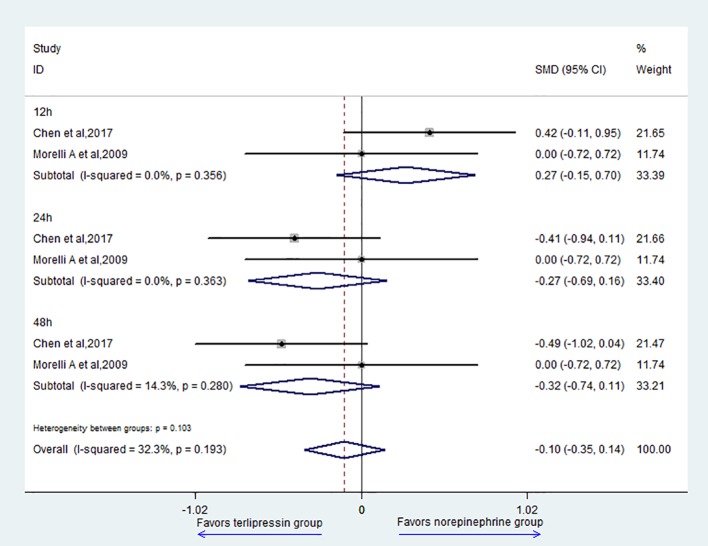
Forest plot of MAP.